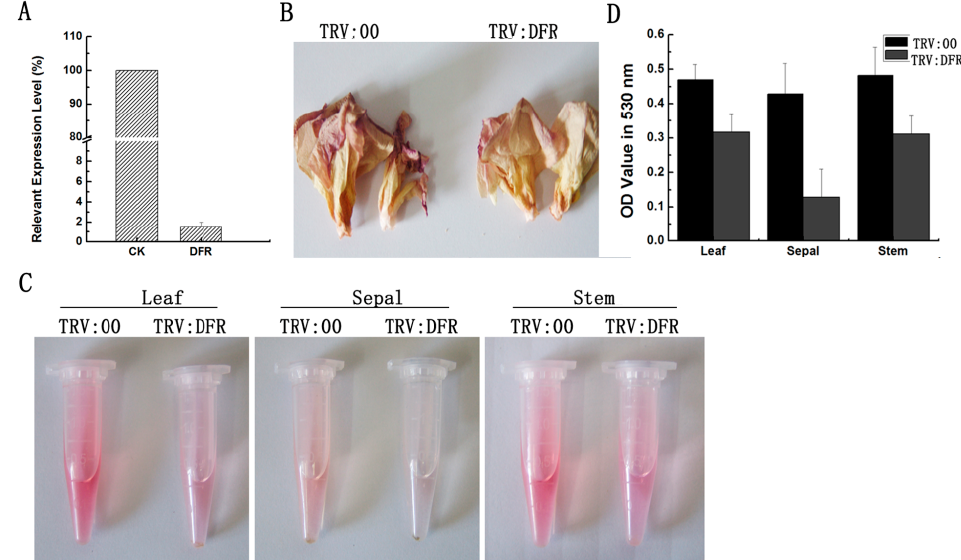
Figure 4. Tissue phenotypes after GhDFR1 knockdown in G. hirsutum by VIGS. ( A ) GhDFR1 expression levels in GhDFR1 -silenced plants and the control by qPCR; ( B ) Petal phenotypes of GhDFR1 -silenced plants and the control; ( C ) Comparison of red color from anthocyanin extracts from leaf, stem, and sepal of GhDFR1 -silenced plants and the control; ( D ) Absorbance values of anthocyanin extracts from leaves, stems, and sepal of GhDFR1 -silenced plants and the control.